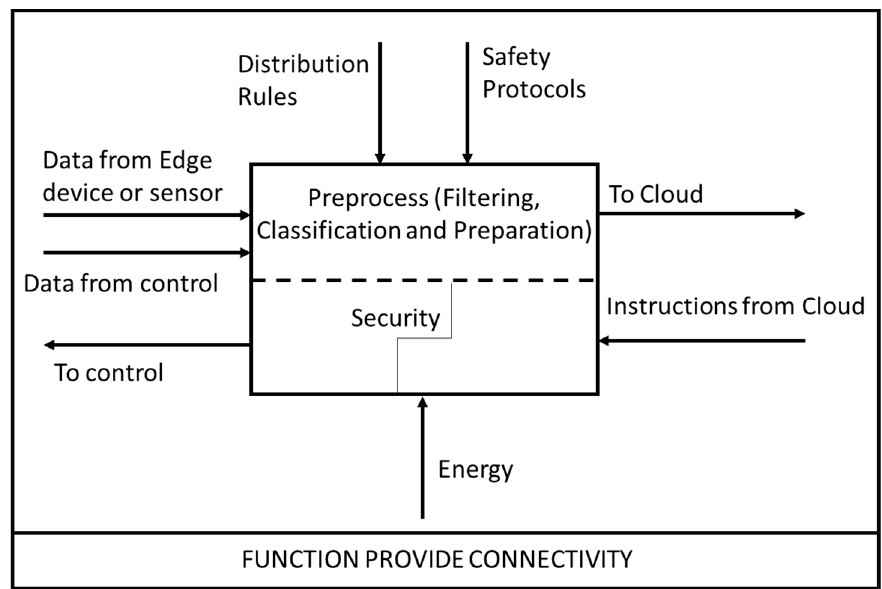
Figure 3. Provide Connectivity function block. Specific actions are performed in this function, as data flows in either